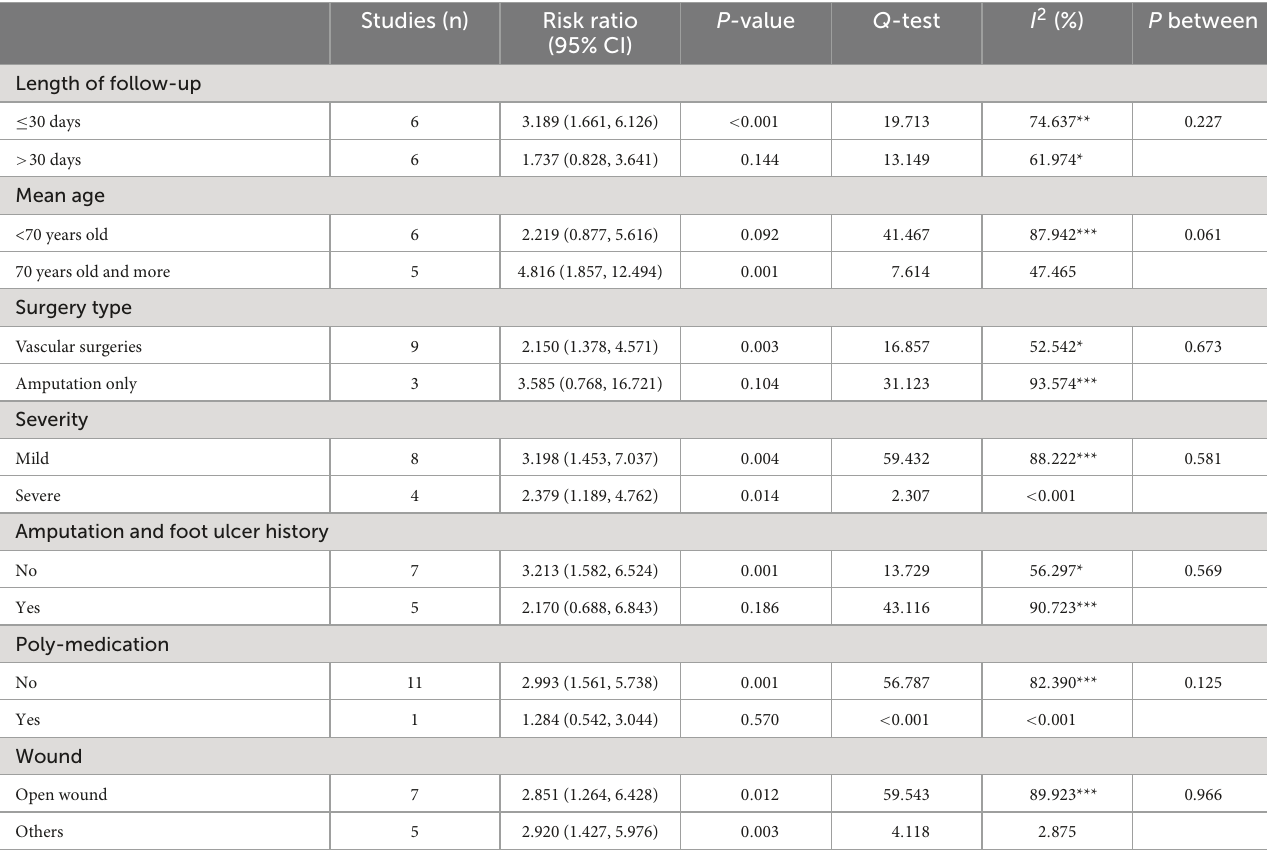
TABLE 3 Subgroup analysis on the association between frailty score and postdischarge mortality.